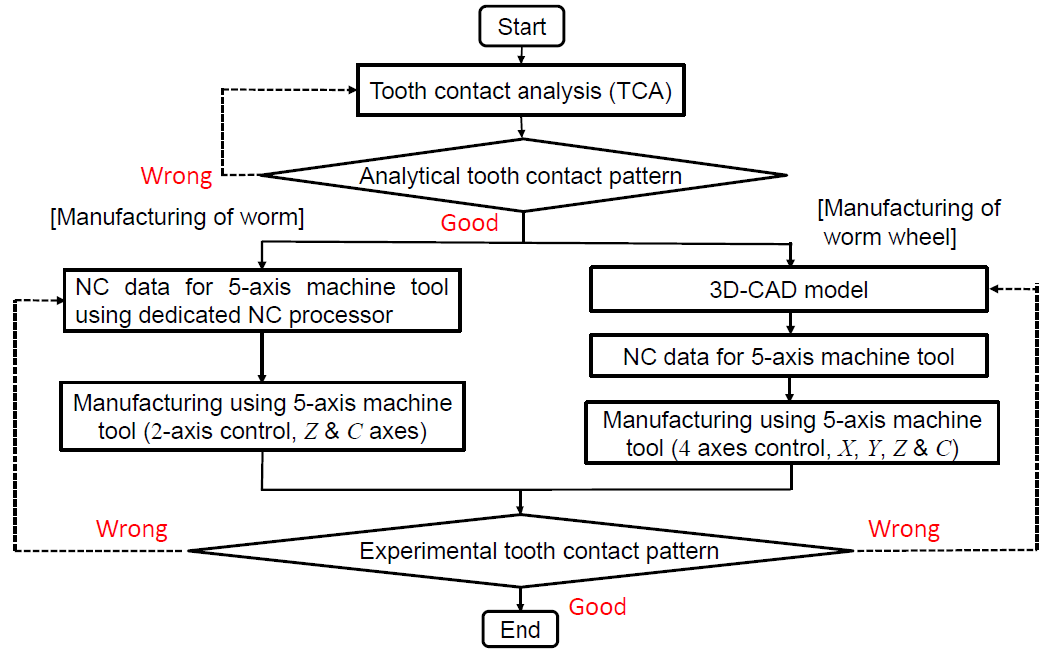
Figure 5. Process for tooth contact analysis and manufacturing of worm gear set using universal CNC machine tools.